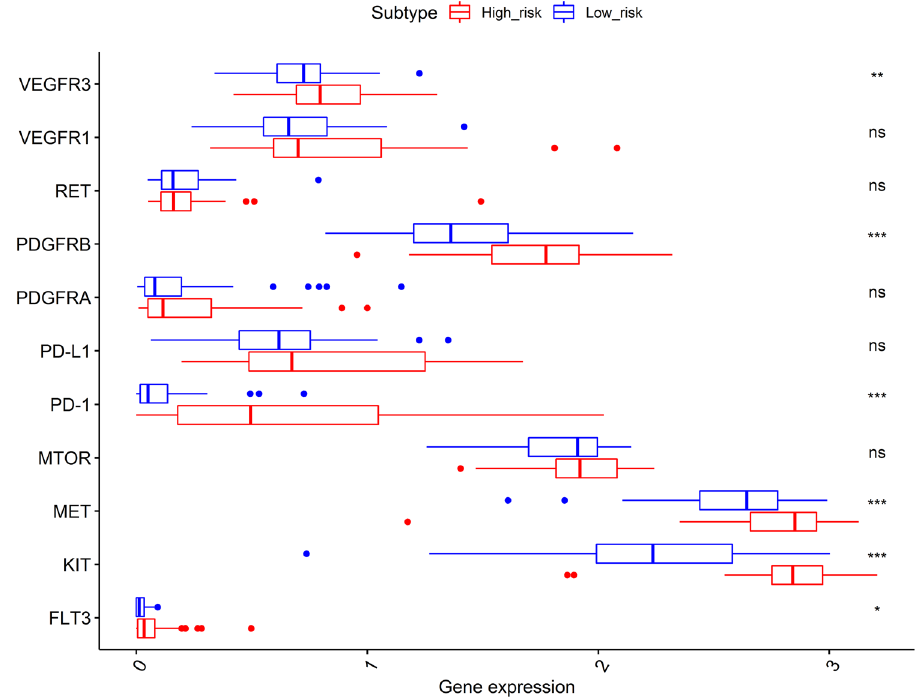
Figure 8. Comparison of the expression levels of immunotherapy and targeted treatment targets between high- and low-risk groups. The figure was performed using R software (version 3.3.1, Vienna, Austria, https:// www.r- proje ct.